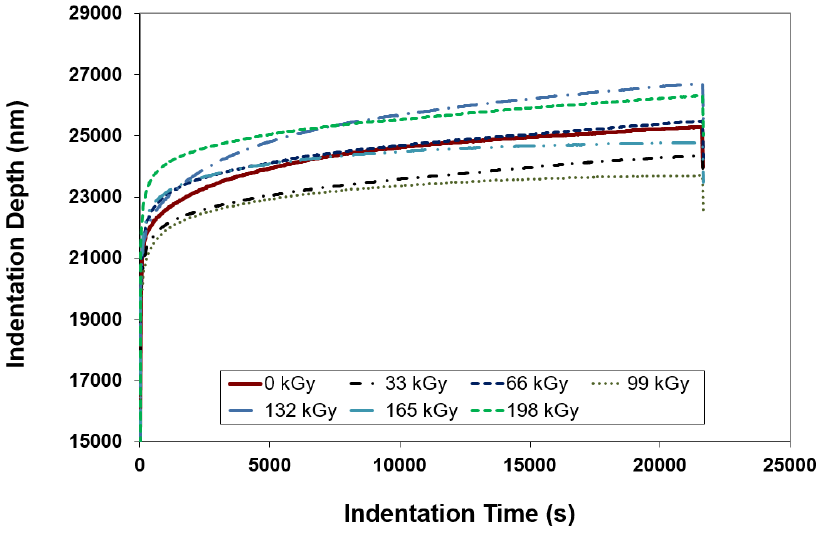
Figure 2. Dependence of indentation depth vs. indentation time of tested PA